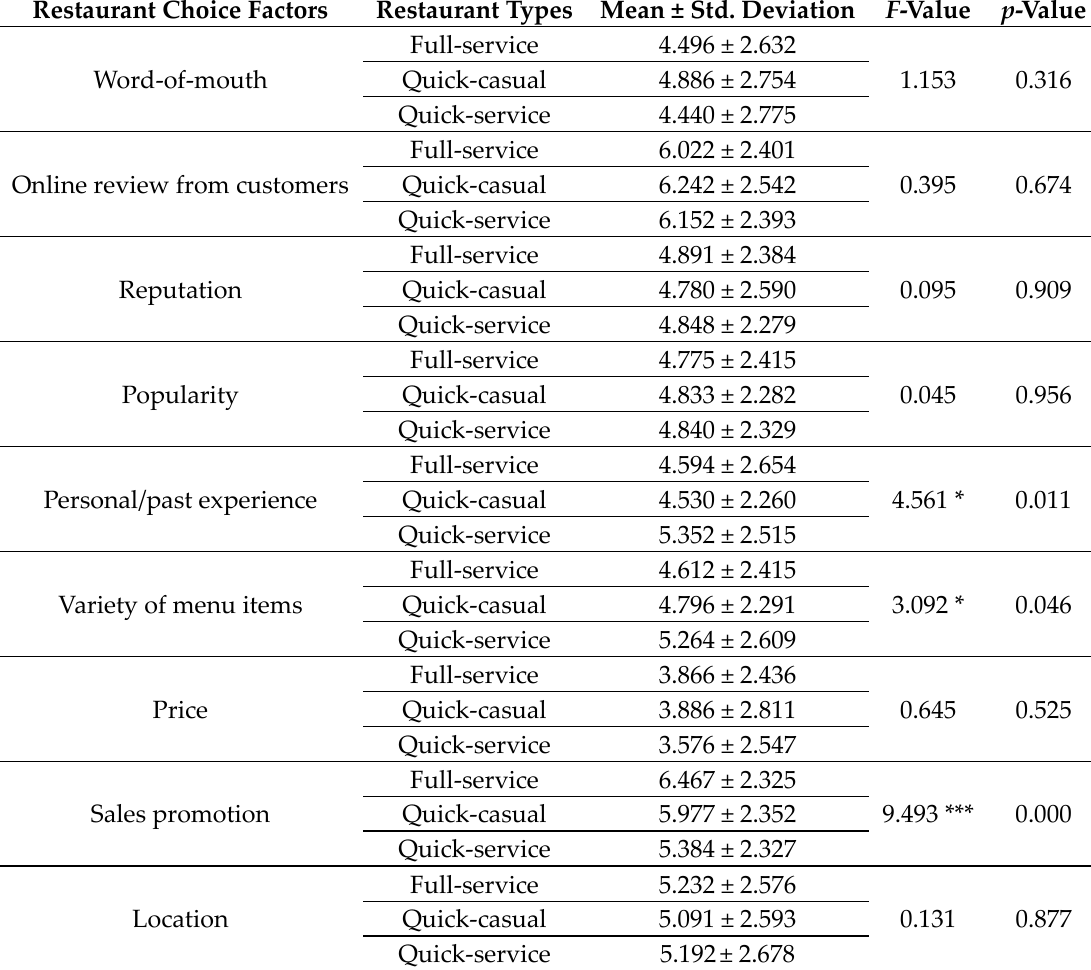
Table 4. Differences in restaurant choice factors across restaurant